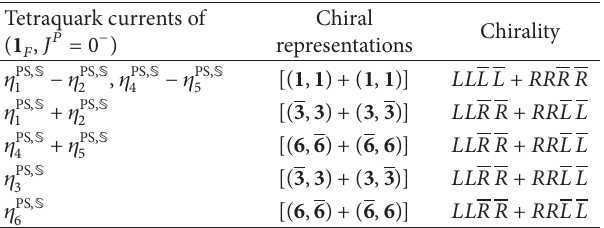
Table 3: Flavor singlet tetraquark currents of 𝐽 𝑃 = 0 − classified in Appendix